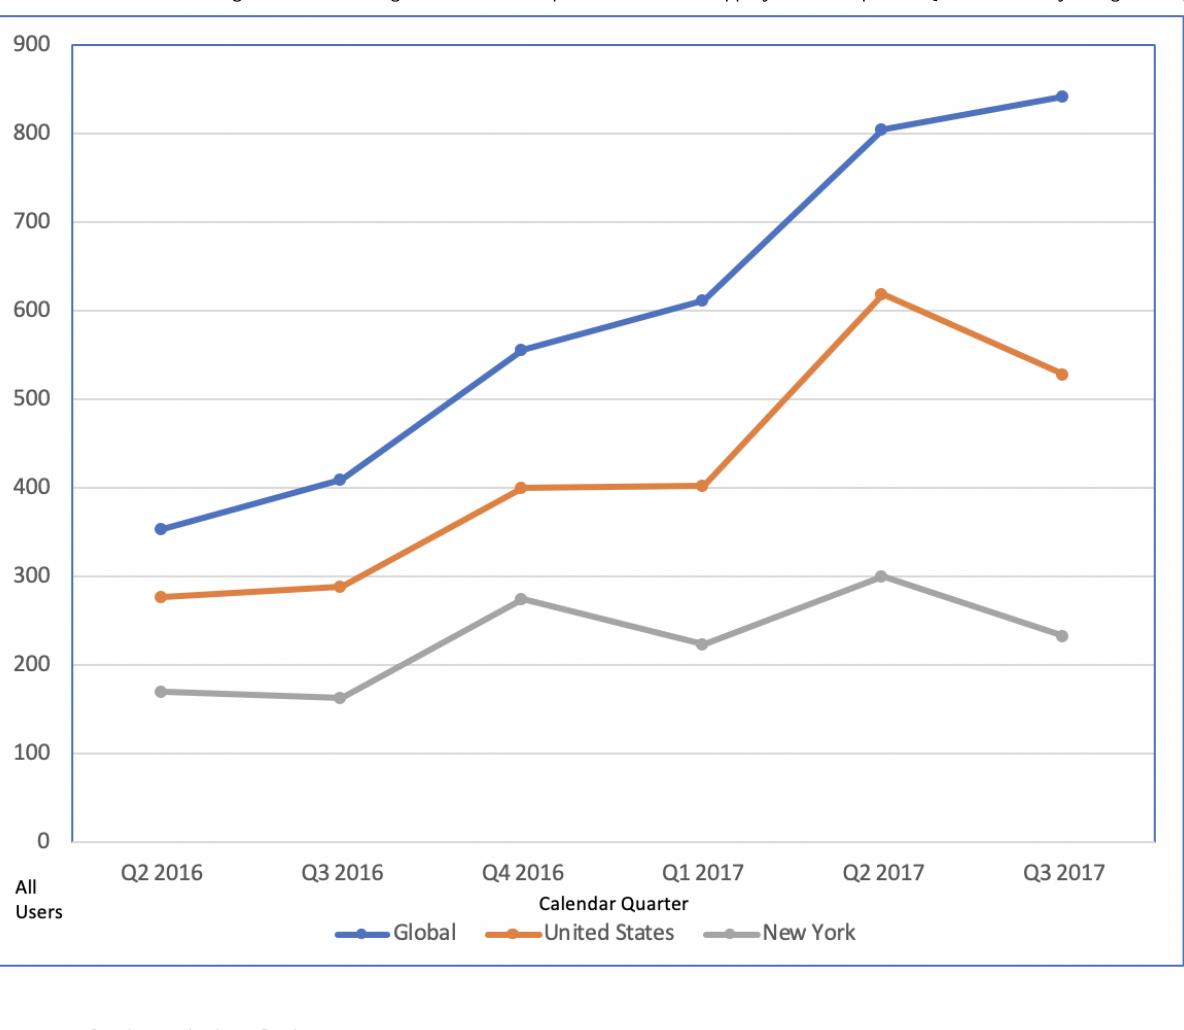
Figure 2. All users of the Management of Anticoagulation in the Periprocedural Period App by calendar quarter (Q) as defined by Google Analytics.